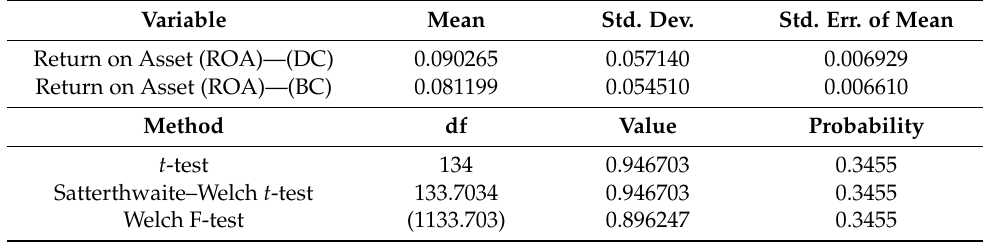
Table 2. The result of ROA.